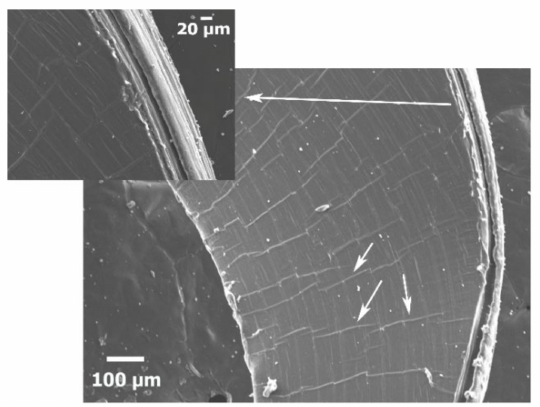
Figure 3. SEM images of the fracture surface of SCB-PE after tensile